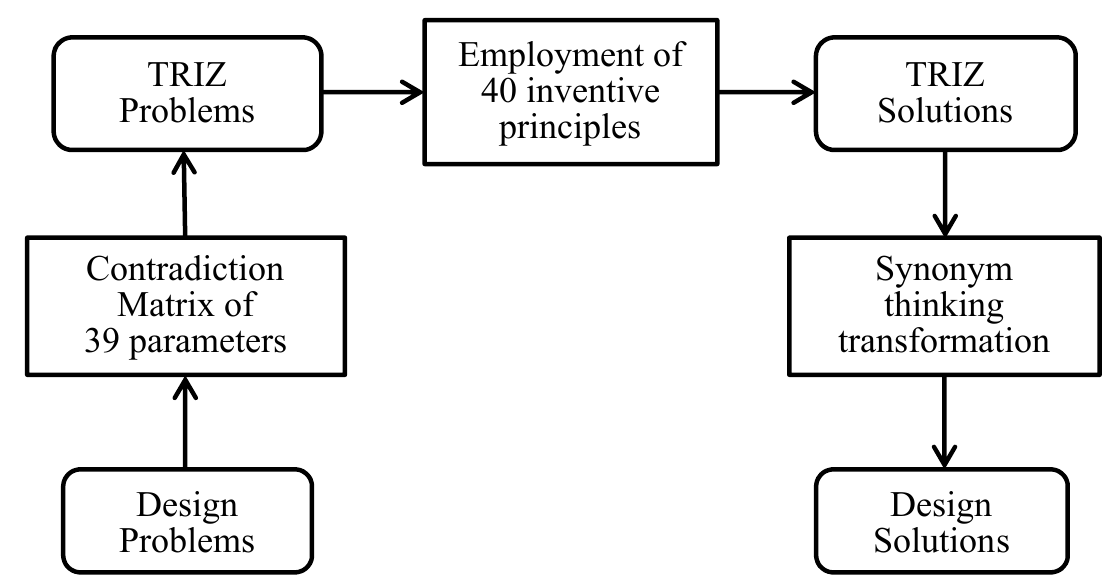
Figure 1. Conceptual schema of the theory of inventive problem-solving (TRIZ)